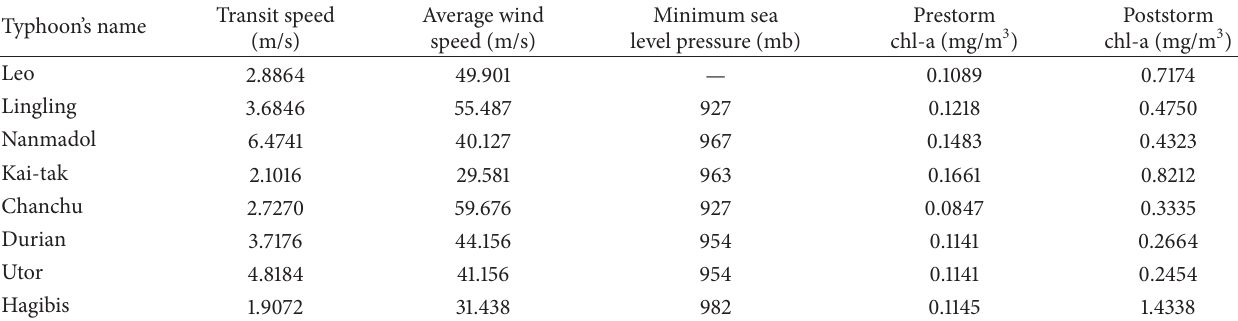
Table 1: Typhoon information and the spatial average chl-a concentration before and after typhoon overlaid on CCE.